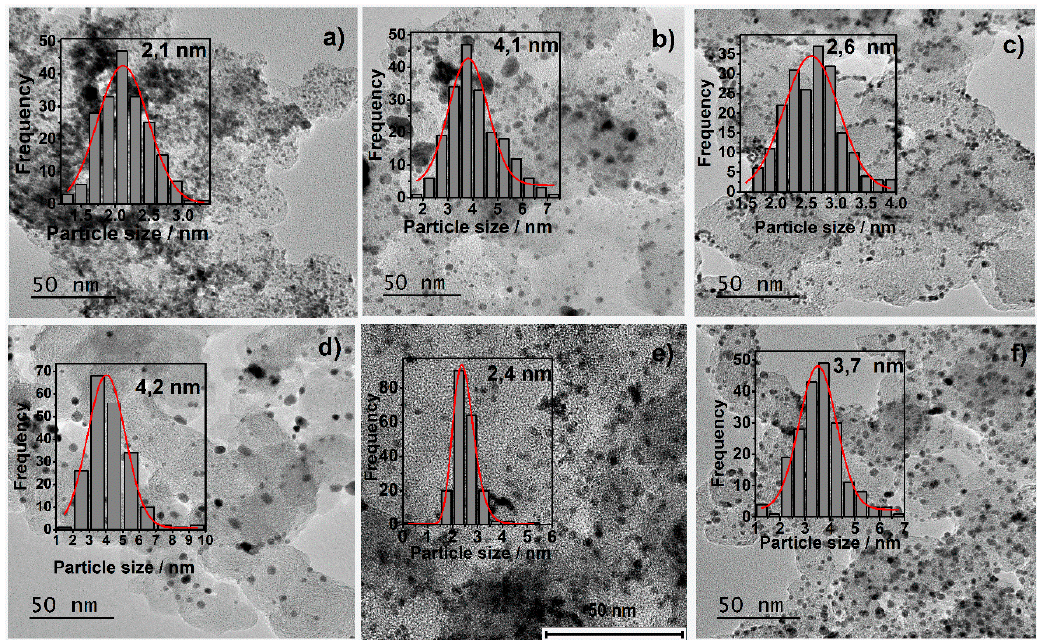
Figure 2. TEM micrographs and average particle size measured from 200 nanoparticles of the catalysts before and after thermal treatment (TT): ( a ) PtRu/C, ( b ) PtRu(TT)/C, ( c ) Pt 2 RuMo/C, ( d ) Pt 2 RuMo(TT)/C, ( e ) Pt 2 RuMo(LBH)/C, and ( f ) Pt 2 RuMo(LBH_TT).